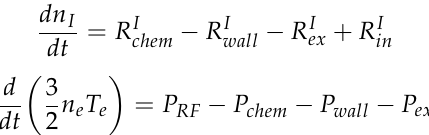
Figure 1. Atmosphere-breathing cathode-less plasma thruster layout and schematic of the global model